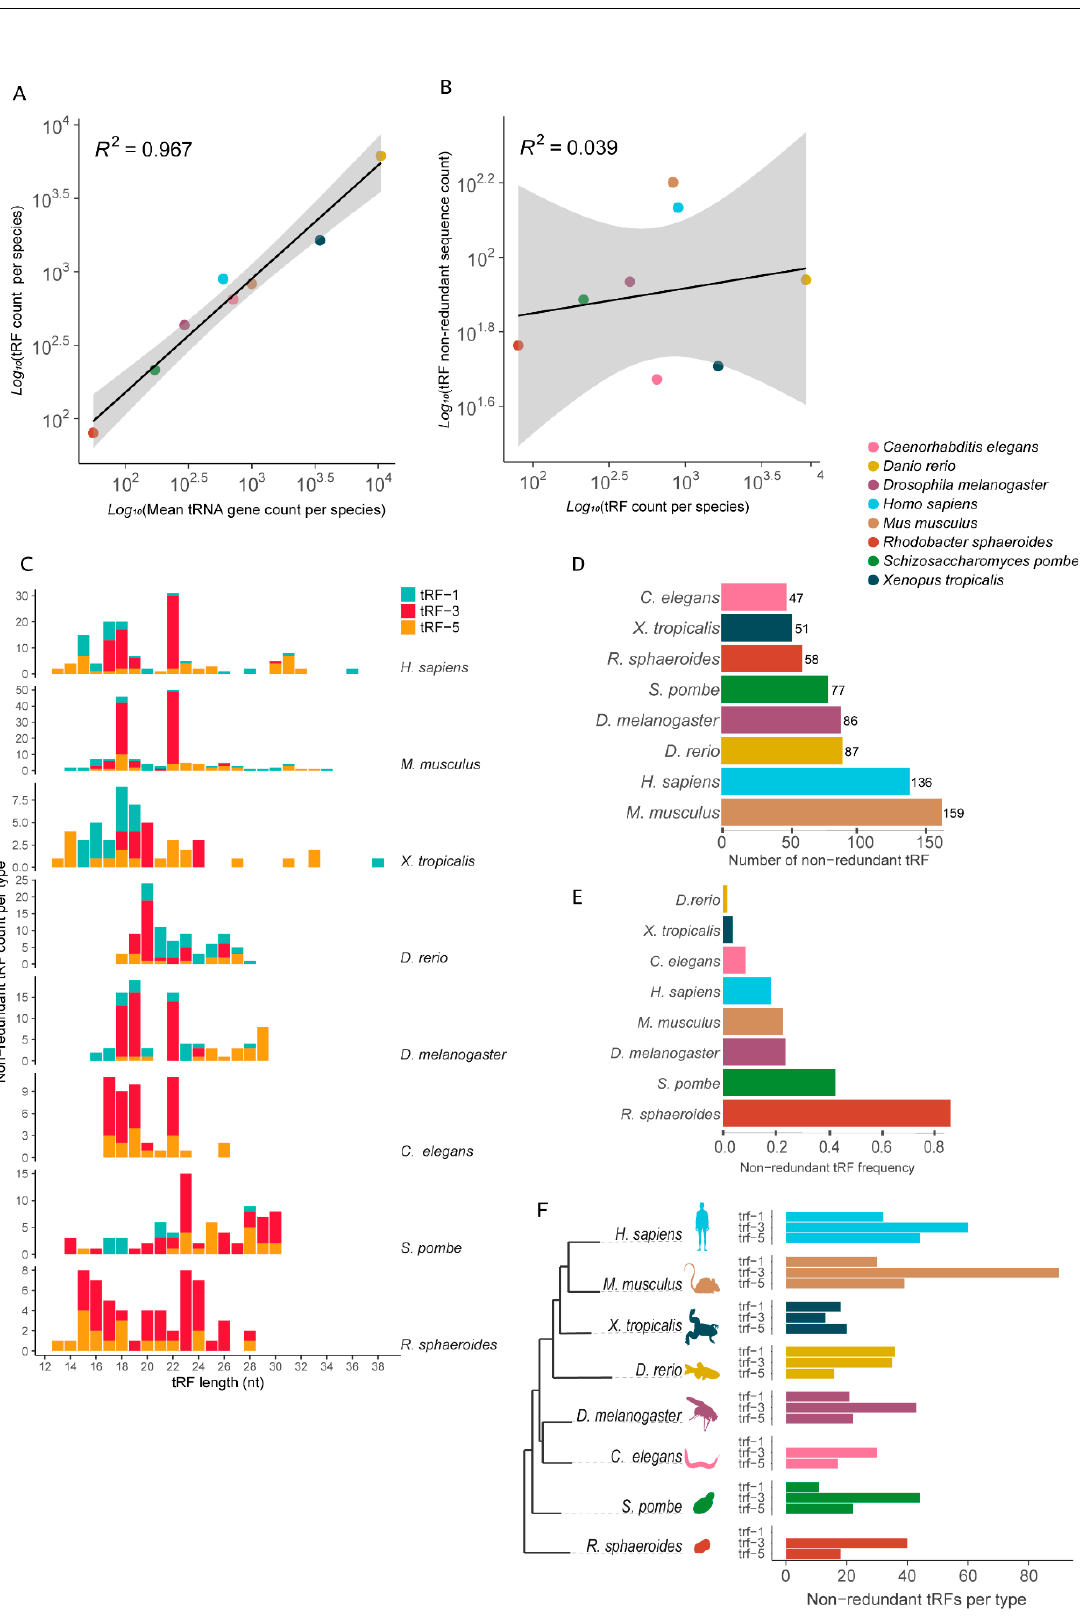
Figure 5. Diversity of tRNA-derived RNA fragments (tRFs) attributes in selected genomes. ( A ) Positive correlation between tRF count and tRNA gene count per species. ( B ) Absence of correlation between non-redundant tRF count and total tRF count between species. ( C ) Distribution of tRF length per type per species (nt). ( D ) Total number of non-redundant tRFs per species. ( E ) Frequency of non-redundant tRFs (non-redundant tRFs/total number of tRFs) per species. ( F ) Number of non-redundant tRFs per type per species in a phylogenetic perspective.